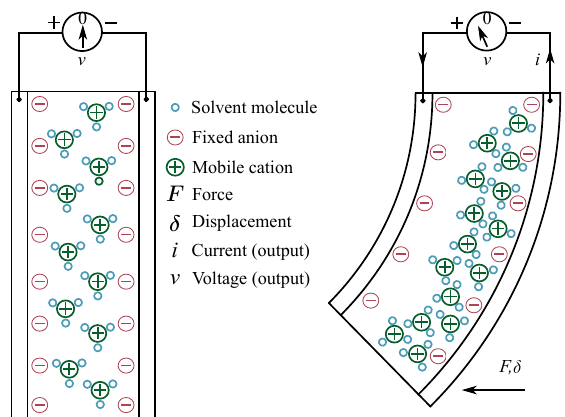
Figure 4. Sensing phenomenon inside IPMCs. Movement of mobile counter-ions causes accumulation of charge in the electrode boundary layers